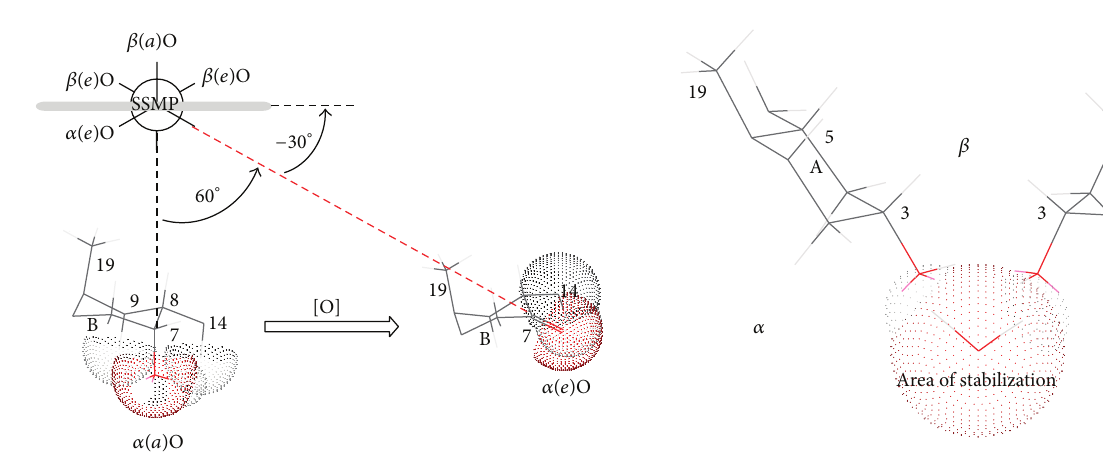
the 𝛽 -side of the steroid skeleton (forming a − 30 ∘ angle with the mean plane of the steroid skeleton of SSMP), that is, towards the hydrophobic interior of mixed micelle.